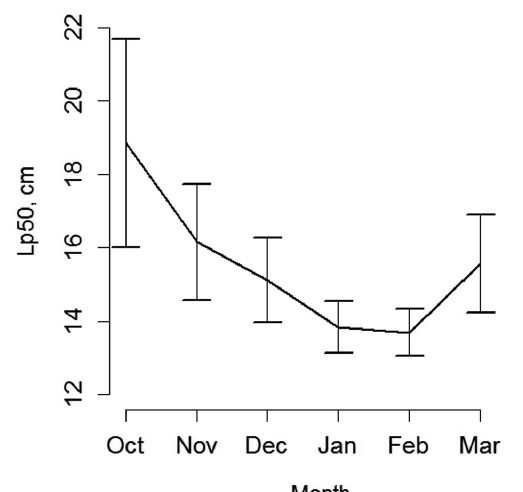
estimates by month during the spawn- 50